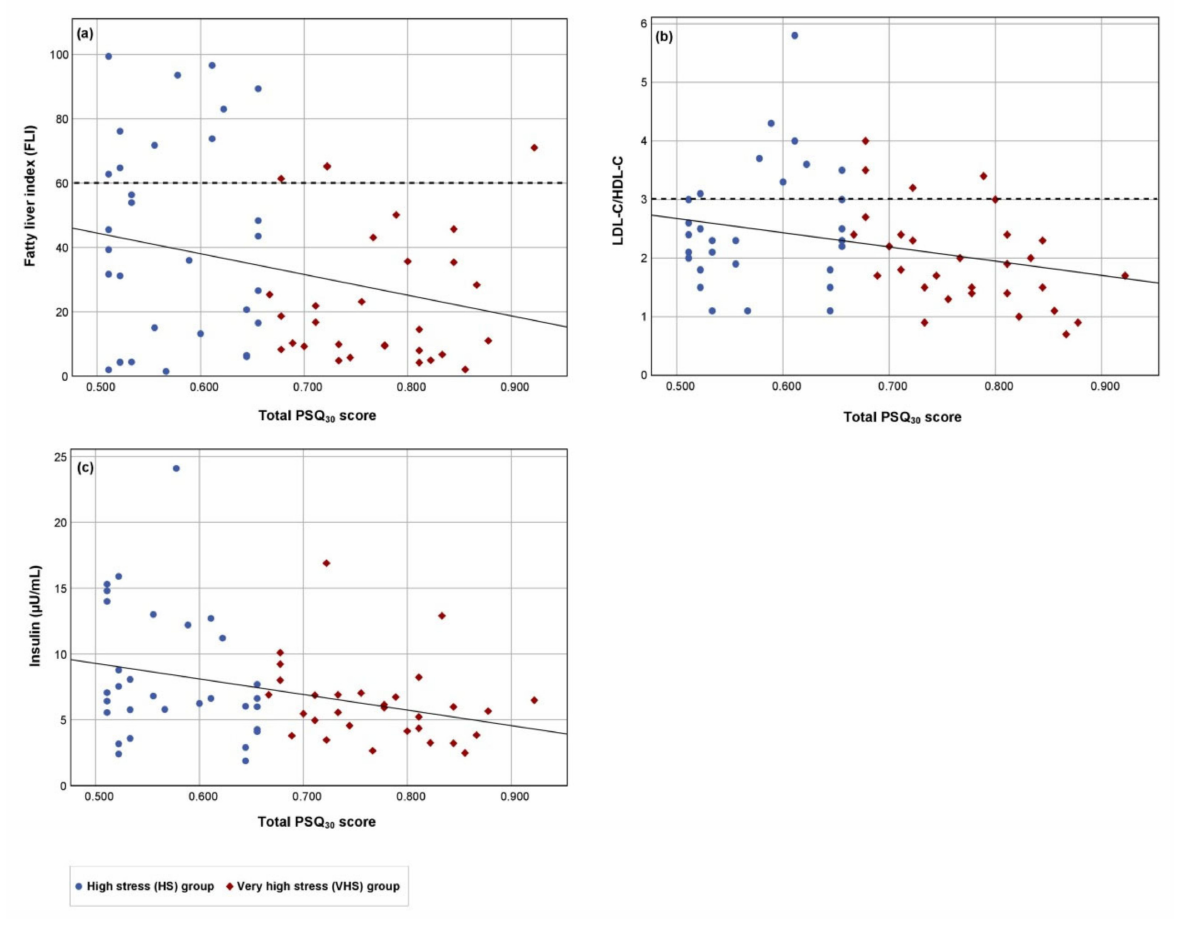
Figure 1. The relationship of the chronic perceived stress load and the cardiometabolic risk in the ITT population. The relationships between the total PSQ 30 score (independent variable) and the depen- dent variables ( a ) fatty liver index, ( b ) LDL-C/HDL-C quotient and ( c ) insulin concentration were examined. Results for the high stress (HS) group ( n = 31), the very high stress (VHS) group ( n = 30), and the cut-off value (dashed line) for FLI and LDL-C/HDL-C quotient are shown. Regression lines: ( a ) Beta value = − 0.266, p = 0.038, 95% confidence interval: − 125.1 to − 3.7; ( b ) Beta value = − 0.294, p = 0.022, 95% confidence interval: − 4.5 to − 0.4; ( c ) Beta value = − 0.330, p = 0.009, 95% confidence interval: − 20.6 to −